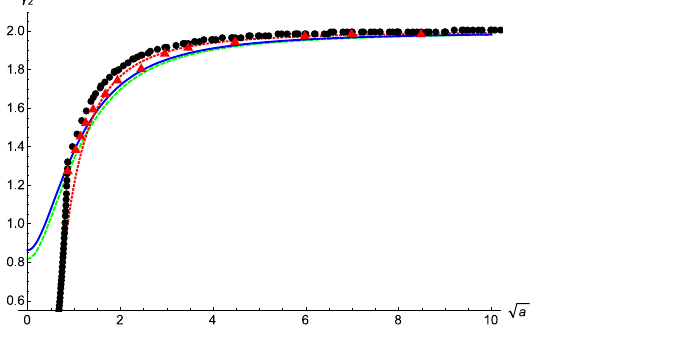
Figure 8 . A similar plot for the spin-2 operator as in (cid:12)gure 5. The red dashed line shows 2 (cid:0) 4 =N 2 , which is numerical (cid:12)tting of the corner values for large- a